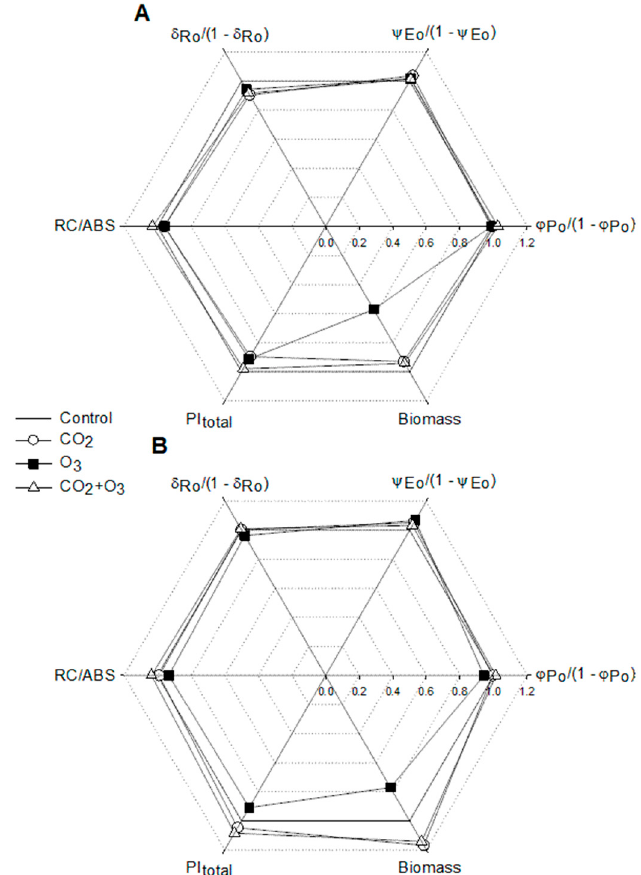
Figure 10. The radar plot of selected biophysical parameters (PI total , RC/ABS, φ Po /(1 - φ Po ), ψ Eo /(1 - ψ Eo ), δ Ro /(1 - δ Ro ) and biomass of wheat. Values were normalized on those of the control, which is shown by the regular hexagon for well-watered ( A ) and water-stressed ( B ) plants. For the JIP-test parameters, the data represent the average of all weeks.